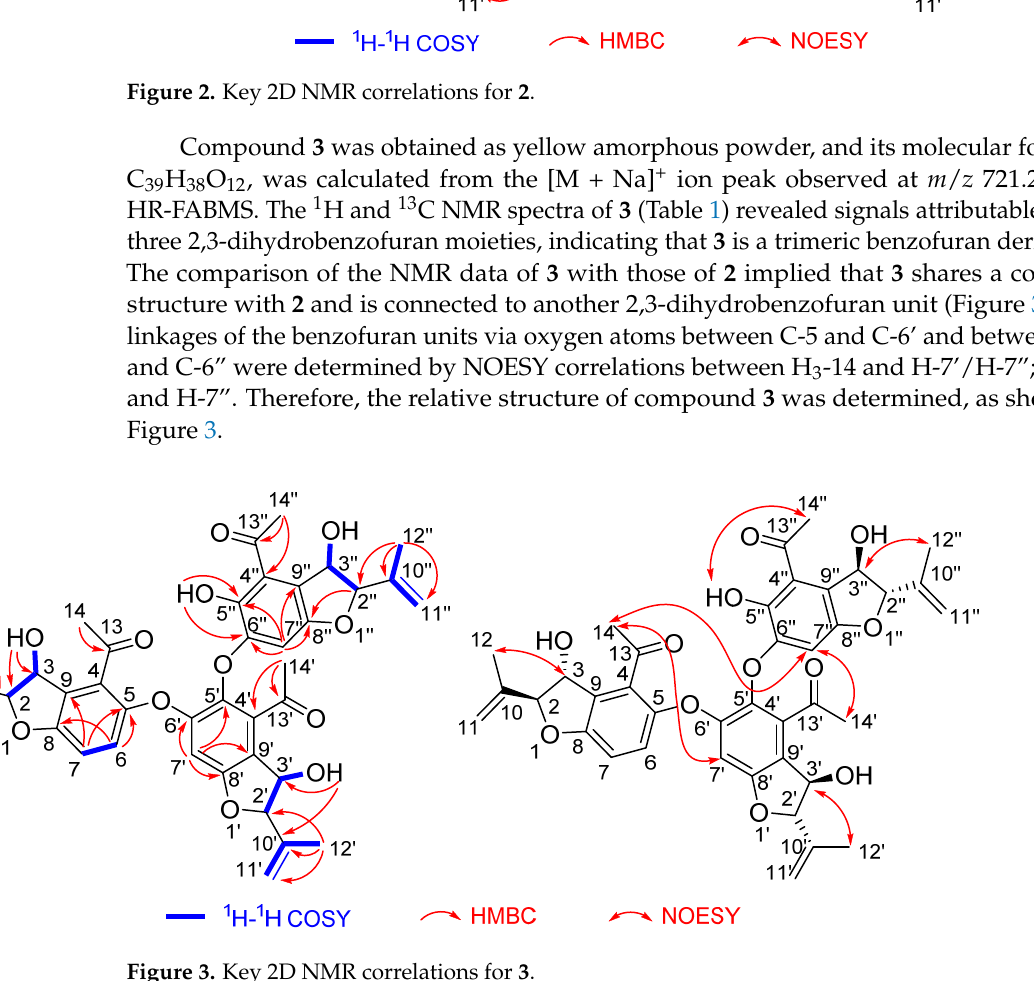
Figure 4. Experimental ECD spectra of 1 – 3 and 29 and calculated ECD spectrum of 2 S ,3 R - 29 . Compound 4 was obtained as yellow amorphous powder. Its molecular formula was determined to be C 26 H 24 O 7 by the [M + H] + peak at m / z 449.1600 in its HRFABMS, indicat- ing 15 degrees of unsaturation. Its 1 H and 13 C NMR data (Table 2), as well as the HMBC correlations (Figure 5) from H-4 to C-3/C-6/C-8/C-13; 6-OH to C-5/C-6/C-7; H-4’ to C-6’/C- 8’/C-13’, and 6’-OH to C-5’/C-6’/C-7’, suggested that 4 consists of two 5-acetyl-6-hy- droxybenzofuran units, such as euparin ( 15 ) [22,23], one of the major constituents of this plant [9]. Furthermore, the 1 H 1 H COSY cross-peak between H 2 -11/H-3’, HMBC correla- tions from H 2 -11 to C-2/C-10/C-2’/C-3’/C-9’, and the molecular formula of 4 indicated that these benzofuran units are linked by a tetrahydrofuran ring composed of C-10 ( δ C 84.6), C-11 ( δ C 43.1), C-3’ ( δ C 49.8), C-2’ ( δ C 122.8), and oxygen between C-10 and C-2’. The NO- ESY correlations of H-3’/H 3 -12’, H 3 -12/H-11’a, H 3 -12’/H-11’b, H-11a/H-3, and H-11a/H-4’ -15 -10-5